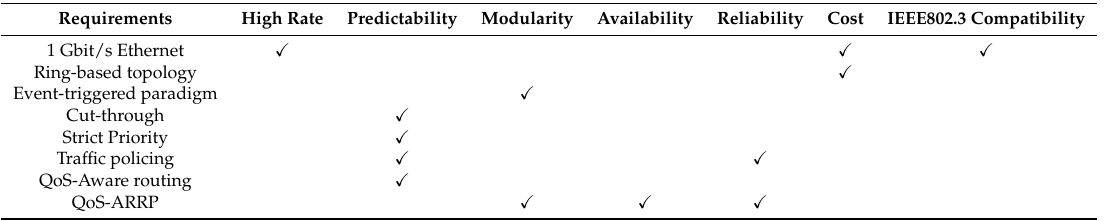
Table 2. AeroRing features vs. avionics